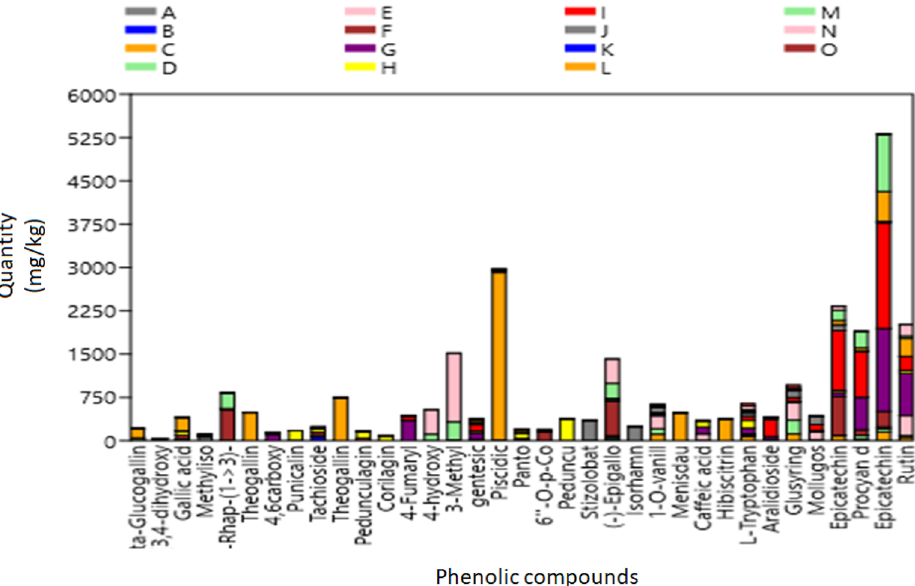
Figure 1. Stacked bar chart of phenolic compounds in different plant species. ( A ) Aloe esculenta, ( B ) Acacia gums, ( C ) Acacia nilotica branch, ( D ) Boscia albitrunca tuber, ( E ) Boscia albitrunca leaves, ( F ) Combretum imberbe roots, ( G ) Colophospermum mopane leaves, ( H ) Combretum imberbe leaves, ( I ) Colophospermum mopane bark, ( J ) Acacia erioloba bark, ( K ) Fockea angustifolia roots, ( L ) Ximenia americana leaves, ( M ) Ziziphus